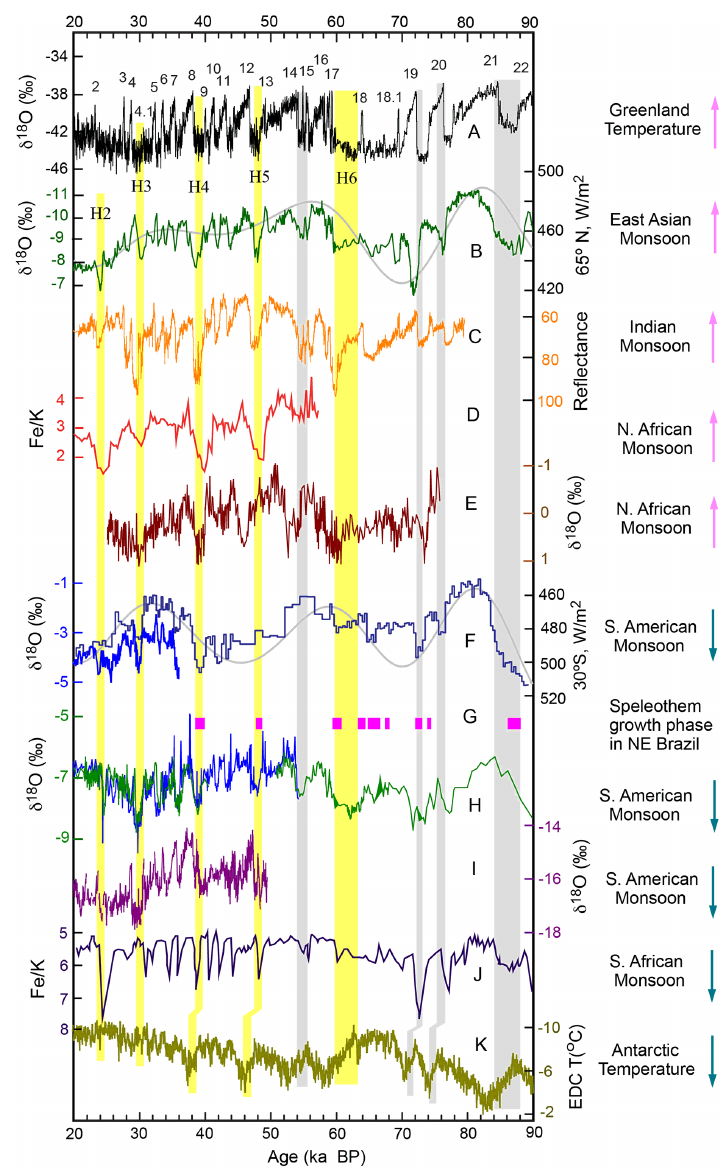
Figure 9. Comparison between millennial events in Asian, American and African monsoon regions. (a) Greenland ice core δ 18 O record (NGRIP, Svensson et al., 2008). (b) East Asian monsoon record composited by using the Hulu and Sanbao records (Cheng et al., 2009a). (c) Indian monsoon record inferred from Arabian Sea sediment total reflectance from core SO130-289KL (Deplazes et al., 2013). (d) Bulk Fe/K ratios from core GeoB9508-5 indicate arid (low) and humid (high) conditions in the North African monsoon region (Mulitza et al., 2008). (e) The North African monsoon proxy record based on the age model tuning to the GISP2 chronology (Weldeab 2012). (f) South American monsoon records from Botuvera Cave (blue, X. Wang et al., 2006; dark blue, X. Wang et al., 2007a). (g) Northeastern Brazil speleothem growth (wet) periods (X. Wang et al., 2004). (h) South American monsoon record from northern Peru (Cheng et al., 2013). (i) South American monsoon record from Pacupahuain Cave (Kanner et al., 2012). (j) Fe/K record (marine sediment core CD154-17-17K) from the southern African monsoon region (Ziegler et al., 2013) show an anti-phased relationship with the North African counterpart (d) . (k) Antarctic ice core temperature record (EDC, Jouzel et al., 2007). The anti-phased relationship between Northern and Southern Hemisphere summer monsoons is evident for the millennial-scale oscillations. Monsoon millennial events have a clear teleconnection with the Greenland record (a) , and their relationship with the Antarctic record (k) is however still ambiguous. Numbers indicate Greenland interstadials. Vertical yellow bars denote H events (H2–H6), and gray bars indicate correlations between northeastern Brazil wet periods, strong South American events and cold Greenland weak Asian monsoon events. Summer insolation (gray curves) at (b) 65 ◦ N (JJA) and (f) 30 ◦ S (DJF) (Berger, 1978) was plotted for comparison. Arrows on the right side depict anti-phased changes of monsoons between the two hemispheres.